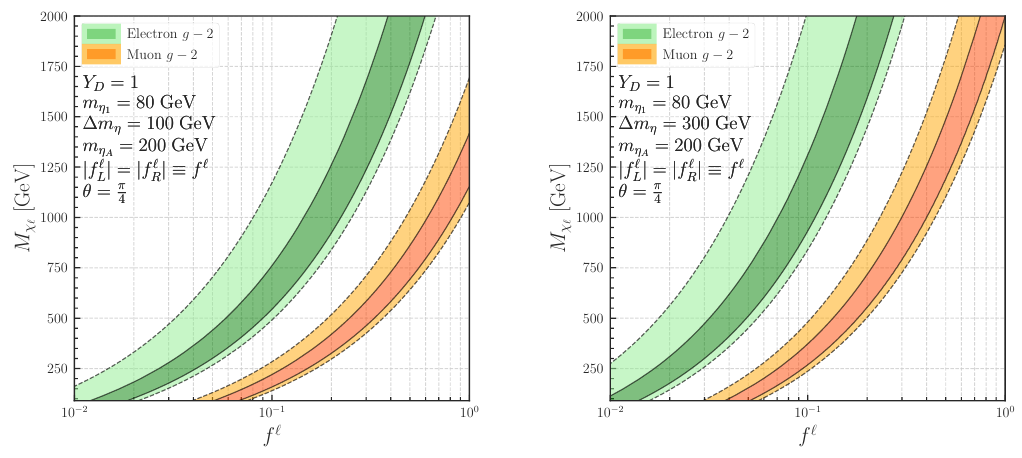
Figure 2 . Regions in the plane of f ‘ ( g 2) ‘ for the scenario of Y D = 1 at the 1 (cid:27) (darker color) and 2 (cid:27) (lighter color) (cid:0)